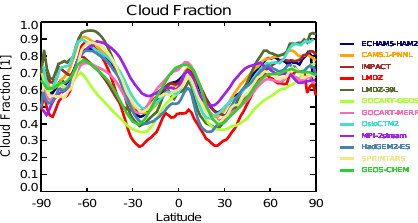
Fig. A1. Annual zonal-mean cloud fractions for experiment FIX0 (AOD=0.0).